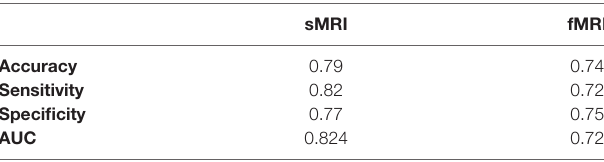
TABLE 2 | The comparison between random forest, SVM, naive Bayes, and neural network results for the global fusion.